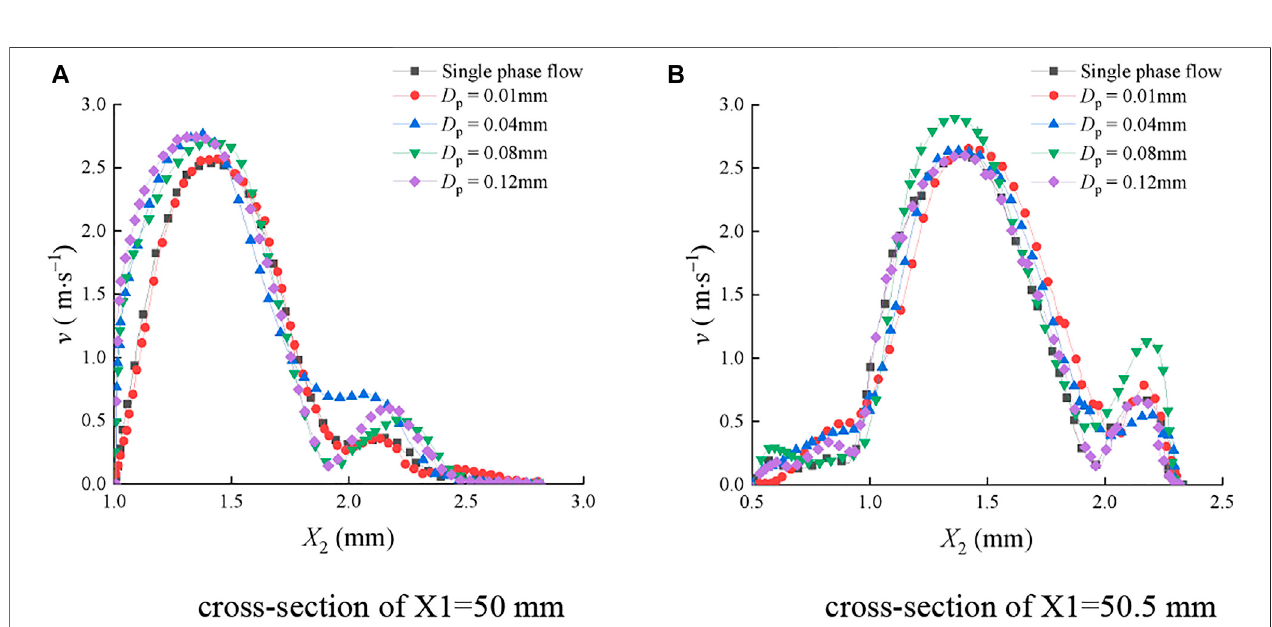
FIGURE10| Meanvelocitydistributionofthecontinuous-phase fl uidoncrosssectionsoftheroughfracturewithdifferentsedimentparticlesizes. (A) Crosssection of X1=50 mm; (B) cross section of X1=50.5 mm.